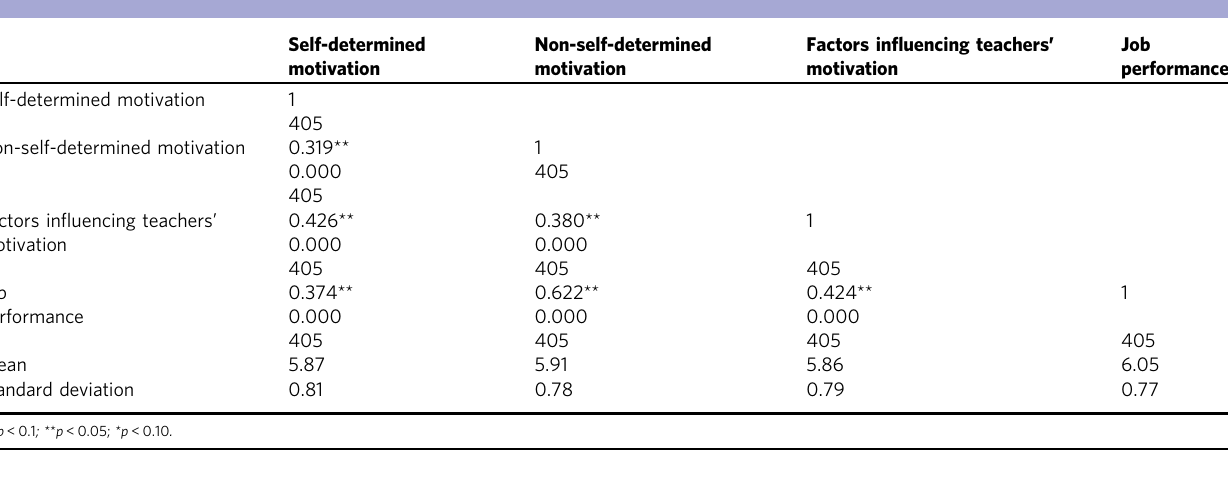
Table 3 Reliability and validity analysis.